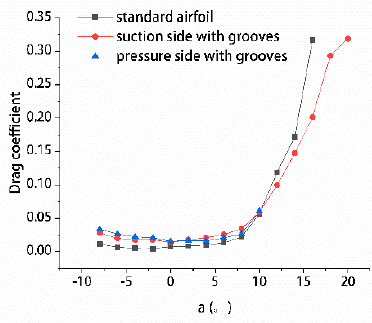
Figure 10. Variation of drag coefficient with angle of attack.